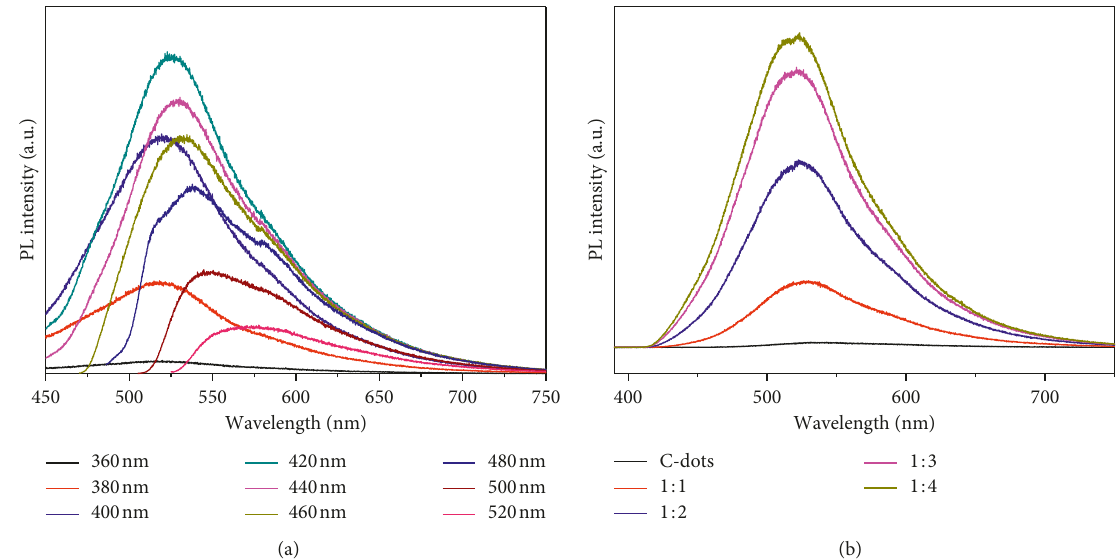
Figure 10: PL spectra of the diluted C-dots in deionized water (C-dots/DW). (a) Effect of excitation wavelength in C-dots/DW ratio of 1:1 specimen and (b) effect of C-dots/DW